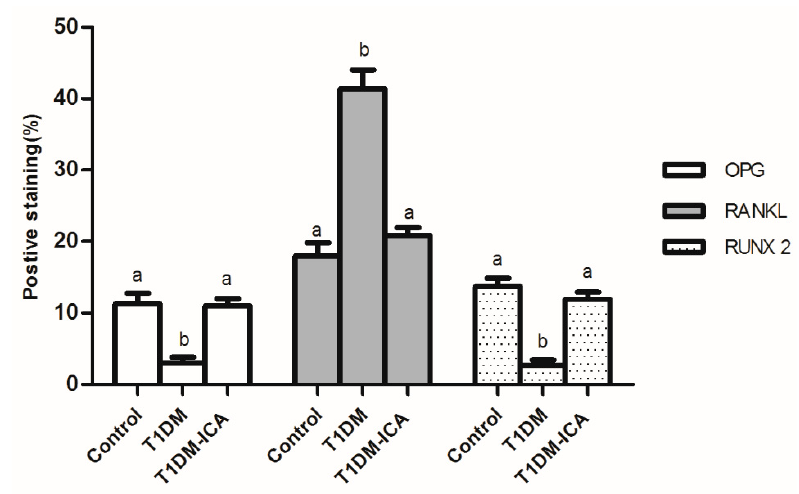
Figure 9. Percentage (%) of the positive staining area of OPG, RANKL, and RUNX 2 in the femoral bone tissues of each group. Values are presented as means ± SD. Different letters (a and b) indicate statistically significant difference ( p < 0.05).